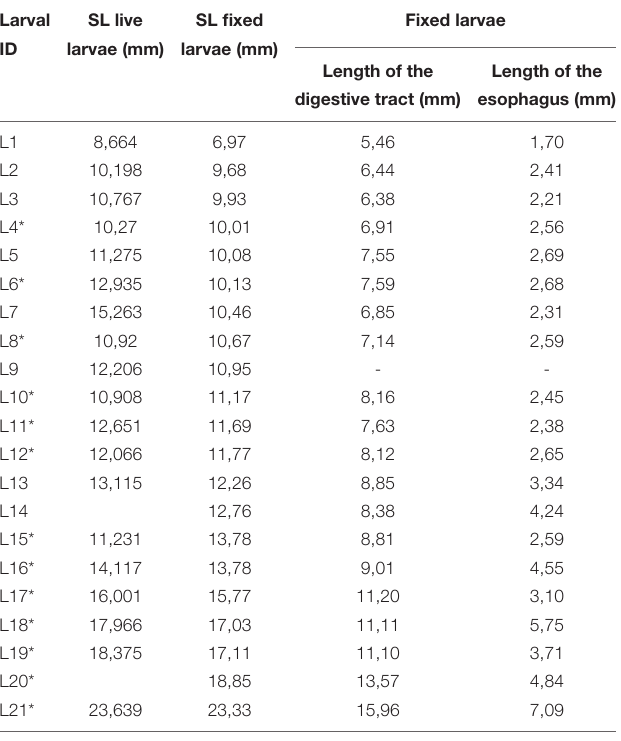
Larvae were measured live after catch and after fixation. The * shows larvae used for histology/electron